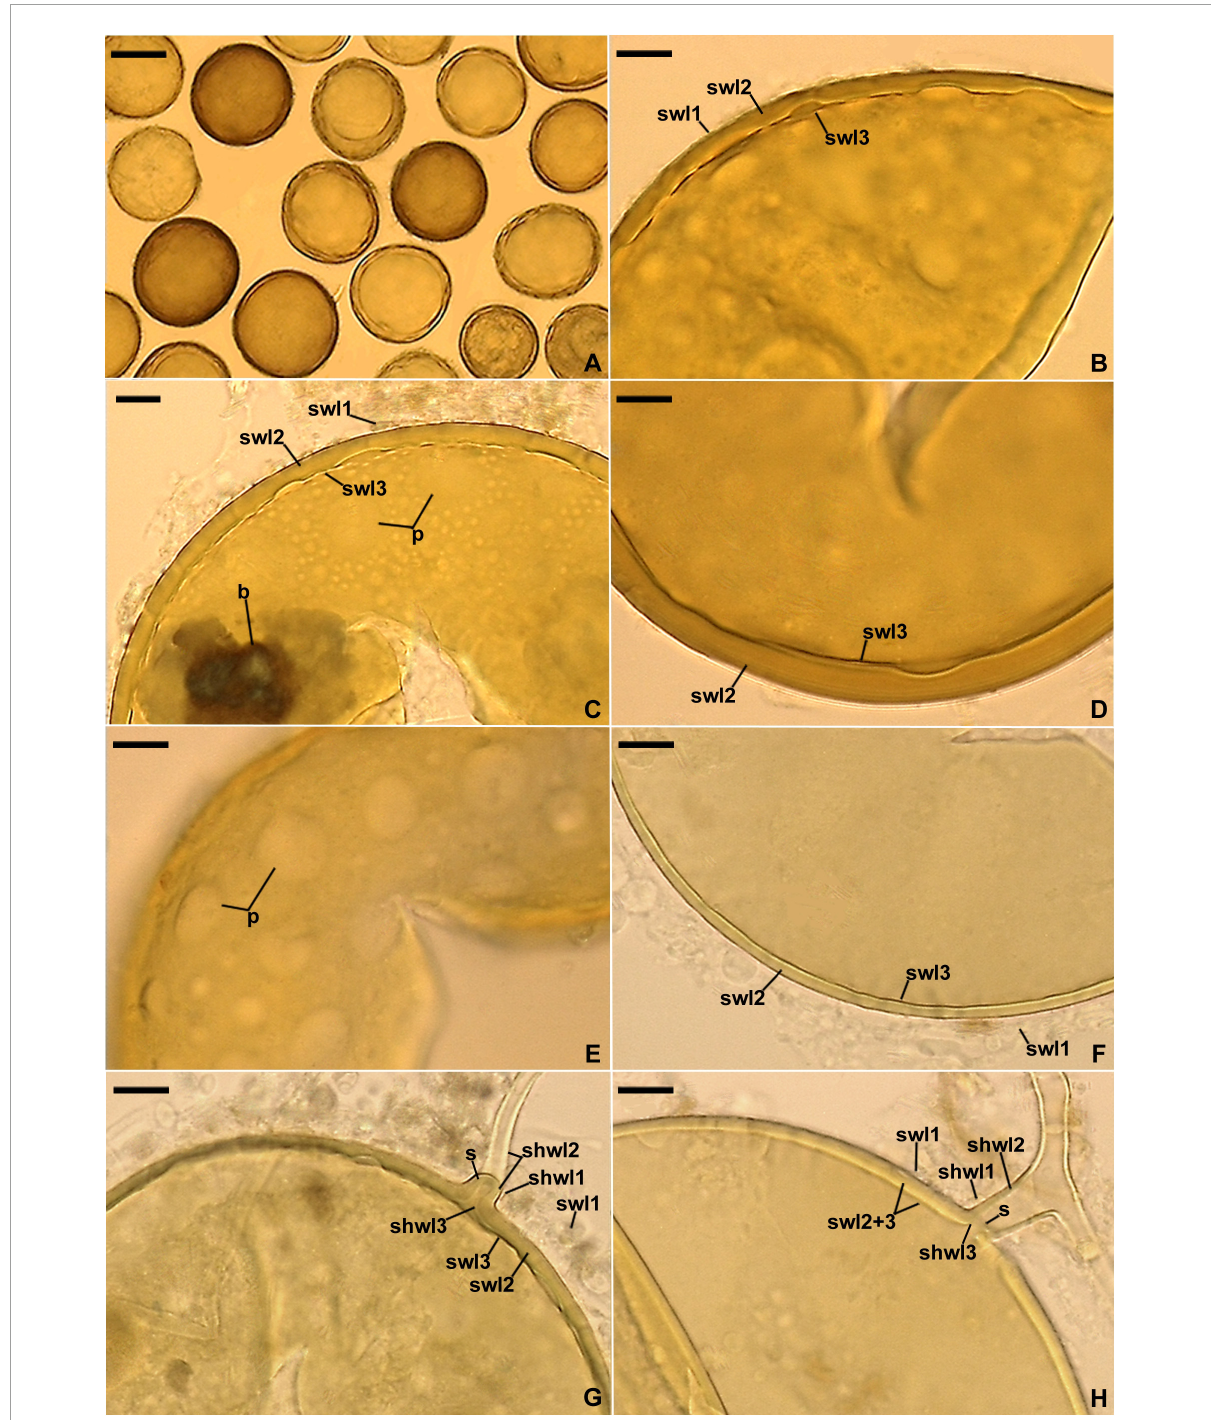
FIGURE6 Entrophospora argentinensis . (A) Intact spores. (B–D,F) Spore wall layers (swl) 1–3; note the differences in thickness of the laminate swl2 in mature spores depicted in (B–D) and the equal thickness of swl2 in a young spore presented in (F) , as well as the birefringent (b) properties of layer 2 in polarized light visible in (C) . (E) Circular and ellipsoidal lighter patches (p) formed by the thinner areas of the laminate spore wall layer 2 seen in a plan view. (G,H) Subtending hyphal wall layers (shwl) 1–3 continuous with spore wall layers (swl) 1–3; note the highly deteriorated swl1 and a septum (s) in the subtending hyphal lumen formed by shwl2 and 3 continuous with swl2 and 3. (A,D–H) Spores in PVLG. (B) Spore in PVLG+Melzer’s reagent. (A–H) Differential interference microscopy. Scale bars: (A) = 50 µ m, (B–H) = 10 µ